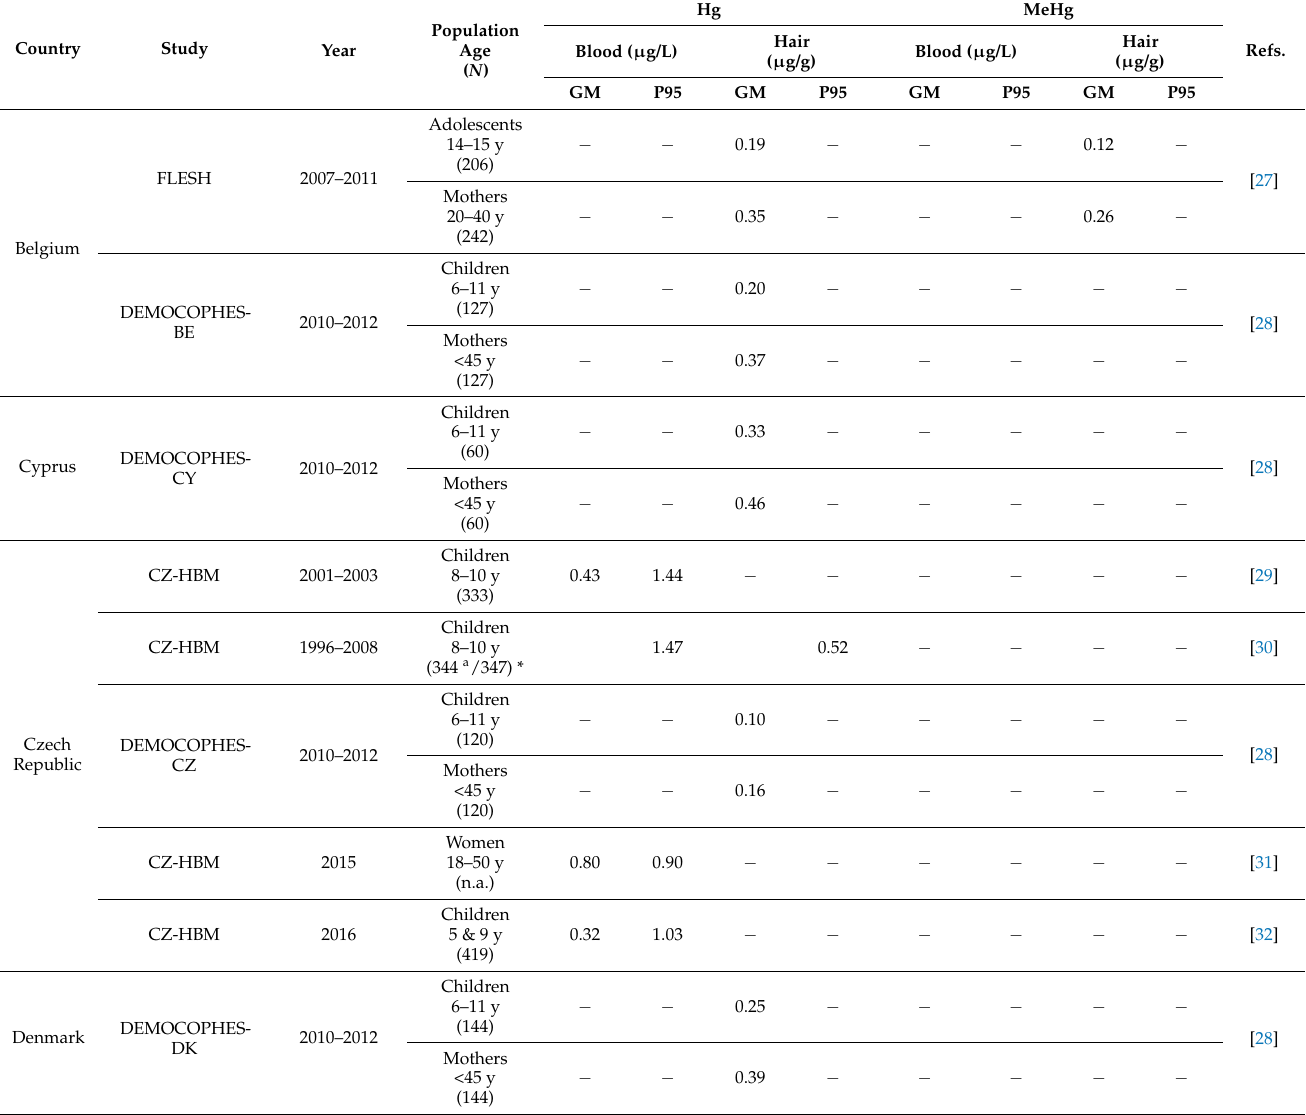
Table 1. Human biomonitoring (HBM) studies with Hg and MeHg data in blood and hair in the selected